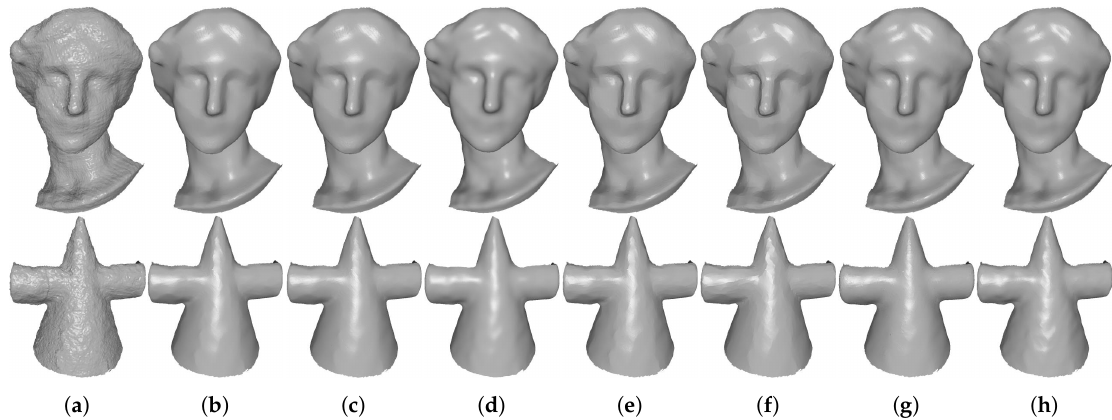
Figure 10. Denoising results of Big-Girl and Cone generated by Kinect-fusion process. From left to right: ( a ) noisy meshes, denoising results produced by ( b ) our method TS; ( c ) HO [1]; ( d ) RHM [14];